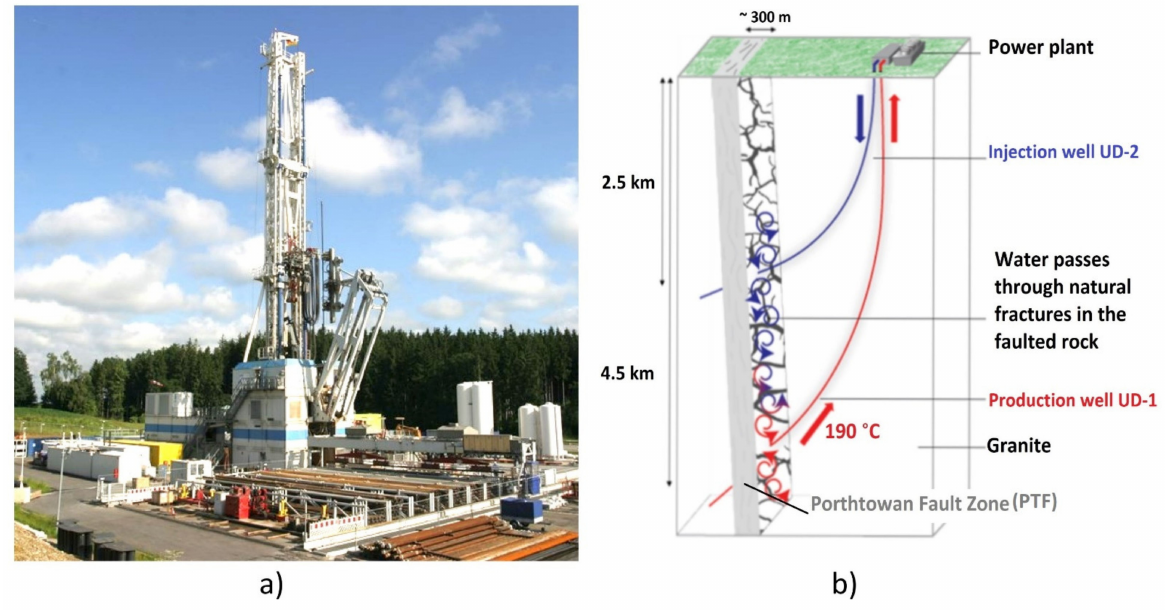
Figure 7. ( a ) The Innovarig hydraulic rig [52]; ( b ) schematic section with the production well (UD-1), injection well (UD-2), and Porthtowan Fault (PTF), modified from Reference